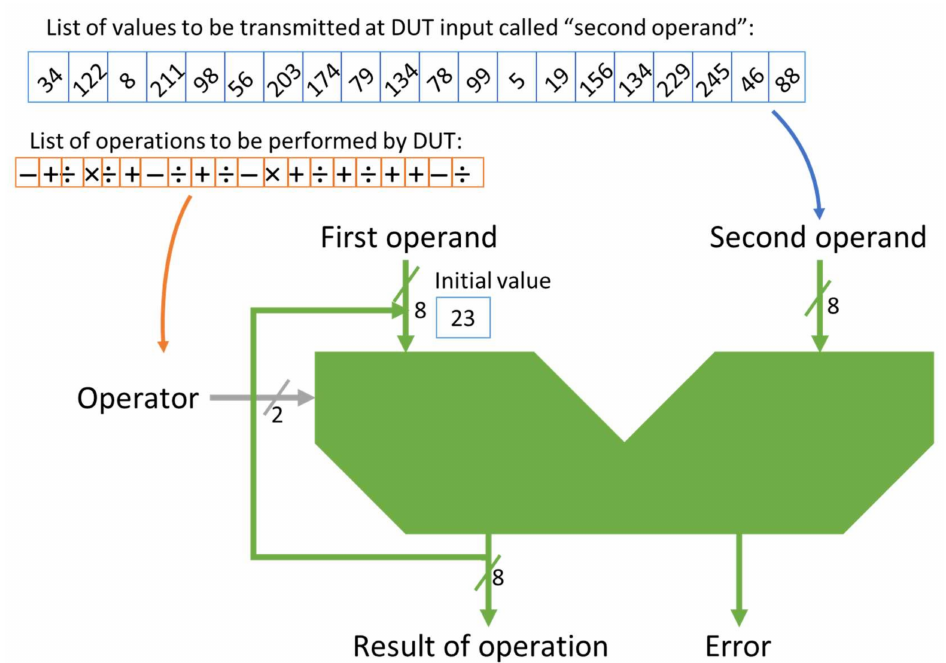
Figure 2. The representation of a DUT representing the Arithmetic Logic Unit and of an example of the data that the ALU receives during a